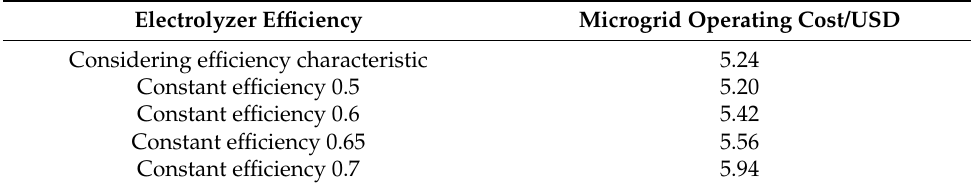
Figure 8. Simulation results under different electrolyzer efficiency models. ( a ) Simulation results of the model considering the efficiency characteristic of the electrolyzer. ( b ) The simulation results of the model using a constant electrolyzer efficiency. Table 3. Operating costs under different electrolyzer efficiency models.